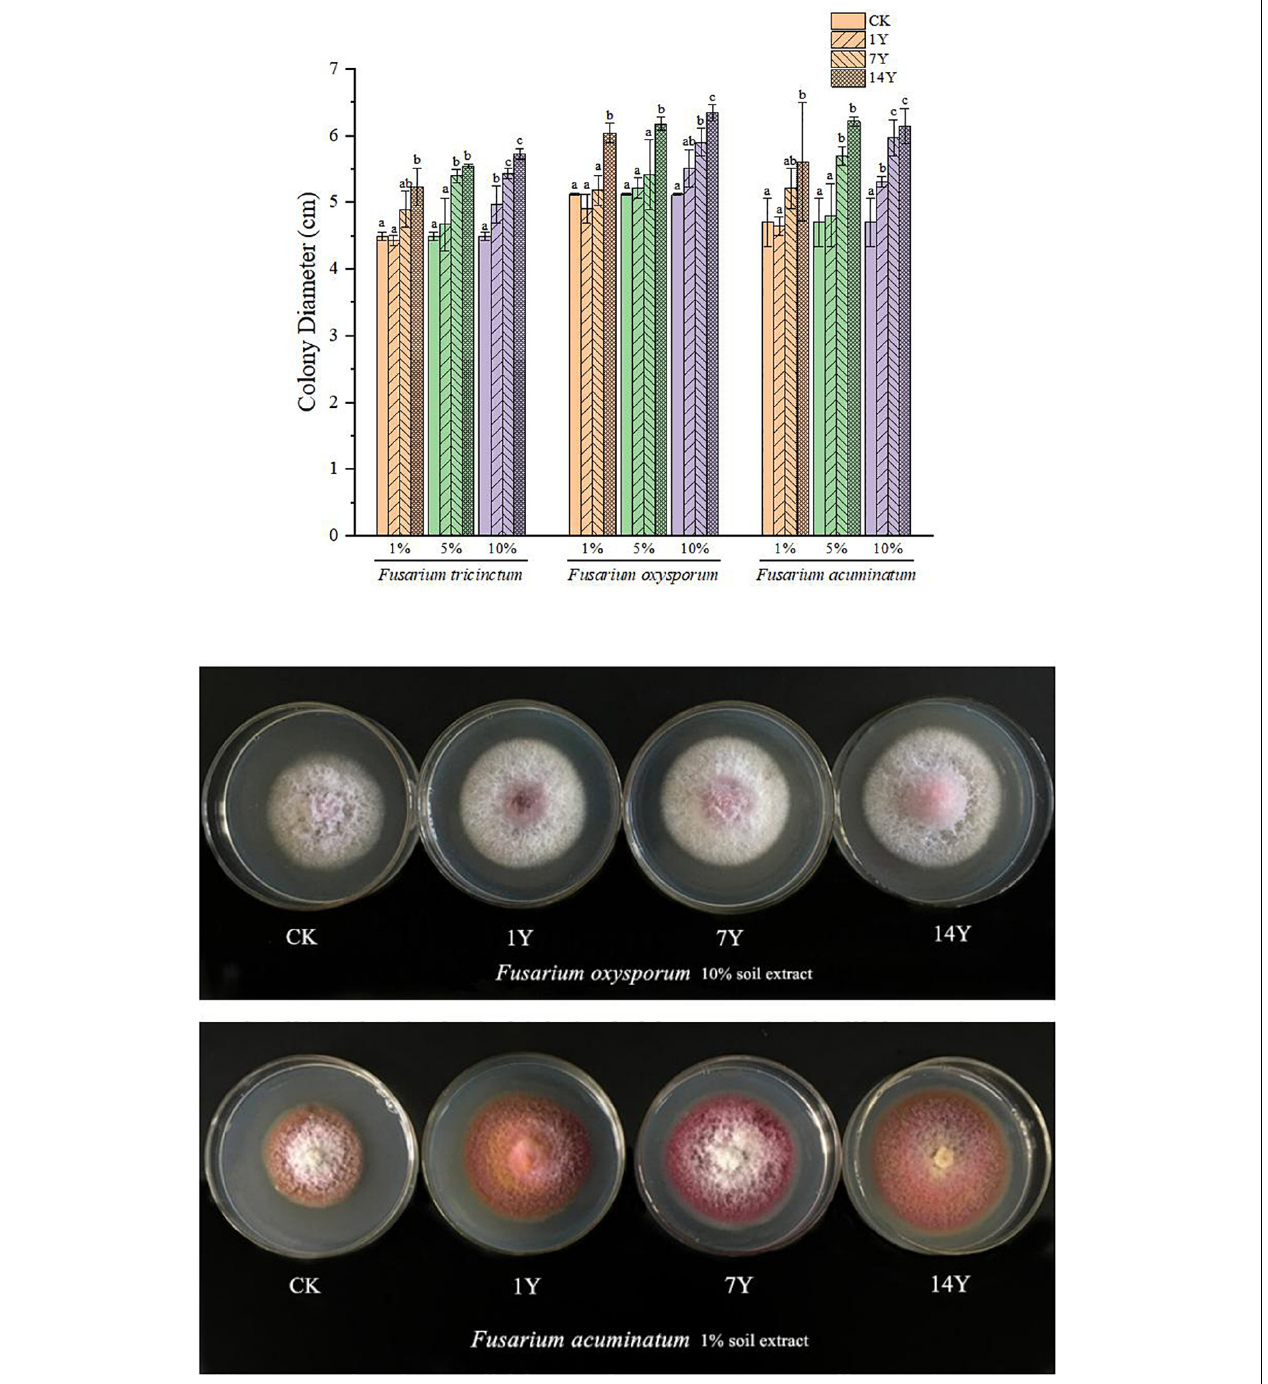
FIGURE 3 | Effect of rhizosphere soil extracts (final concentration VIV: 1, 5, and 10%) from fields with alfalfa continuous cropping for 1, 7, and 14 years on mycelial growth of Fuasrium oxysporum , F. tricinctum , and F. acuminatum that cause alfalfa root rot. Error bars indicate standard errors of the means of three repetitions. Different letters above the bars indicate significant difference according to Duncan ’s multiple range test ( P =